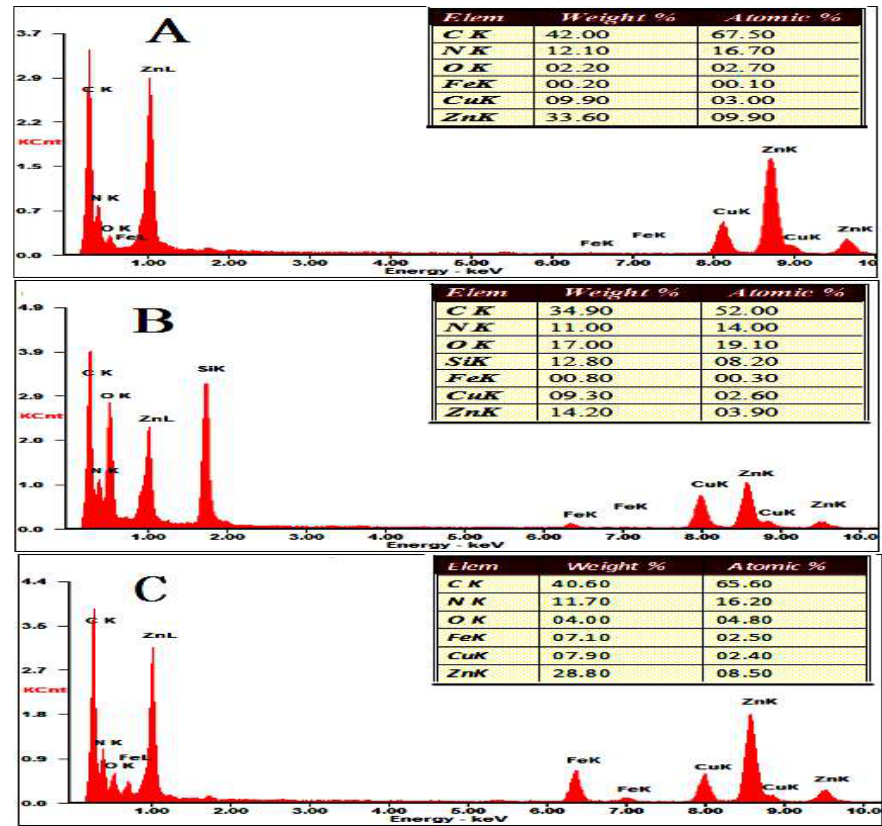
3+ -CA@CAT/ZIF-8 ( C 2 2@CAT/ZIF-8 ( B ), and Fe